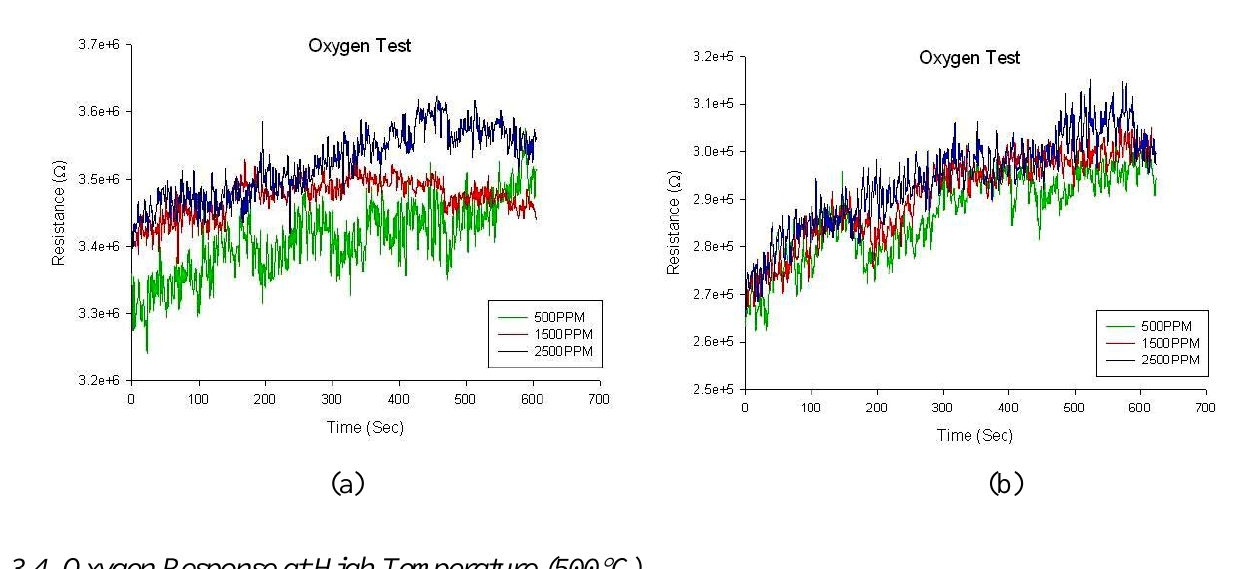
Figure 9. Temporal resistance response vs. different oxygen concentrations at room temperature of 31  C with (a) a plain (non-porous) TiO film. The film thickness is 50